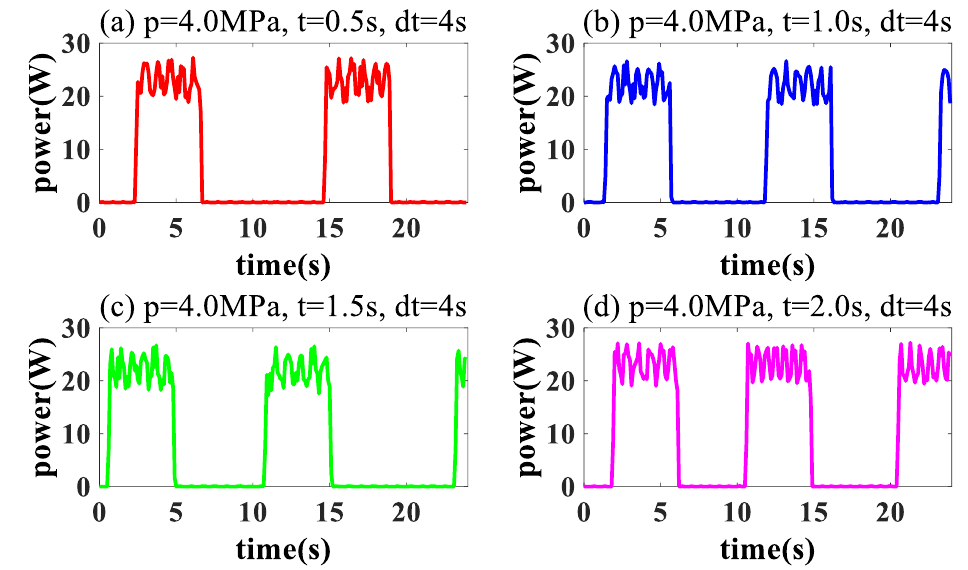
Figure 12. Output power under different delay times (trigger pressure is 4 MPa).